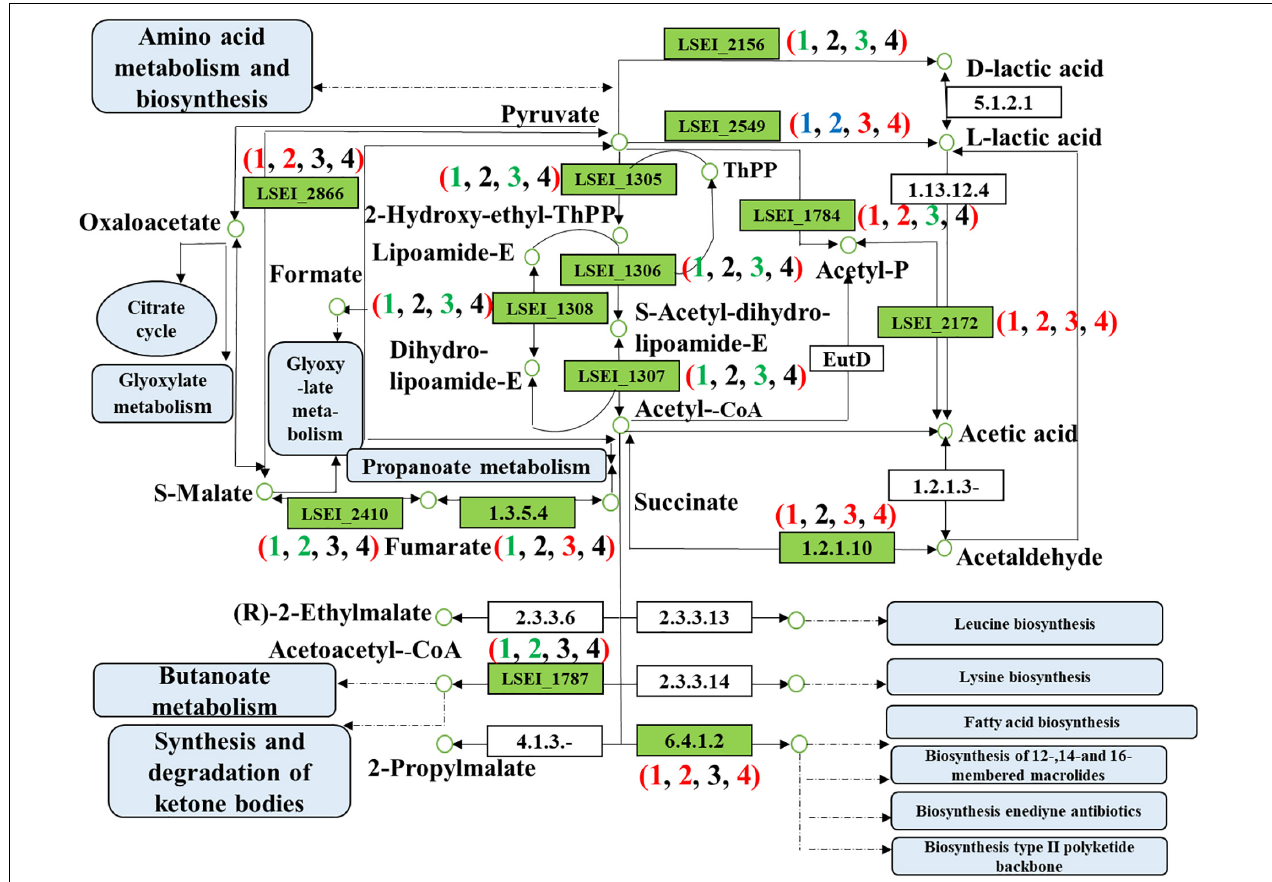
FIGURE 6 | Differentially expressed genes of pyruvate metabolism in four pairwise comparisons (Numbers in brackets 1, 2, 3, and 4 refer to the L3 vs L1 days, LY3 vs LY1 days, LY1 vs L1 days, and LY3 vs L3 days, respectively. L1 day refers to single inoculation with L. paracasei on the first day, L3 day refers to single inoculation with L. paracasei on the third day, LY1 day refers to mix inoculation with L. paracasei and K. marxianus on the first day, LY3 day refers to mix inoculation with L. paracasei and K. marxianus on the third day. The colors red, green, blue, and black represent the up-regulated gene, down-regulated gene, both of up-regulated gene and down-regulated gene, and no change gene,